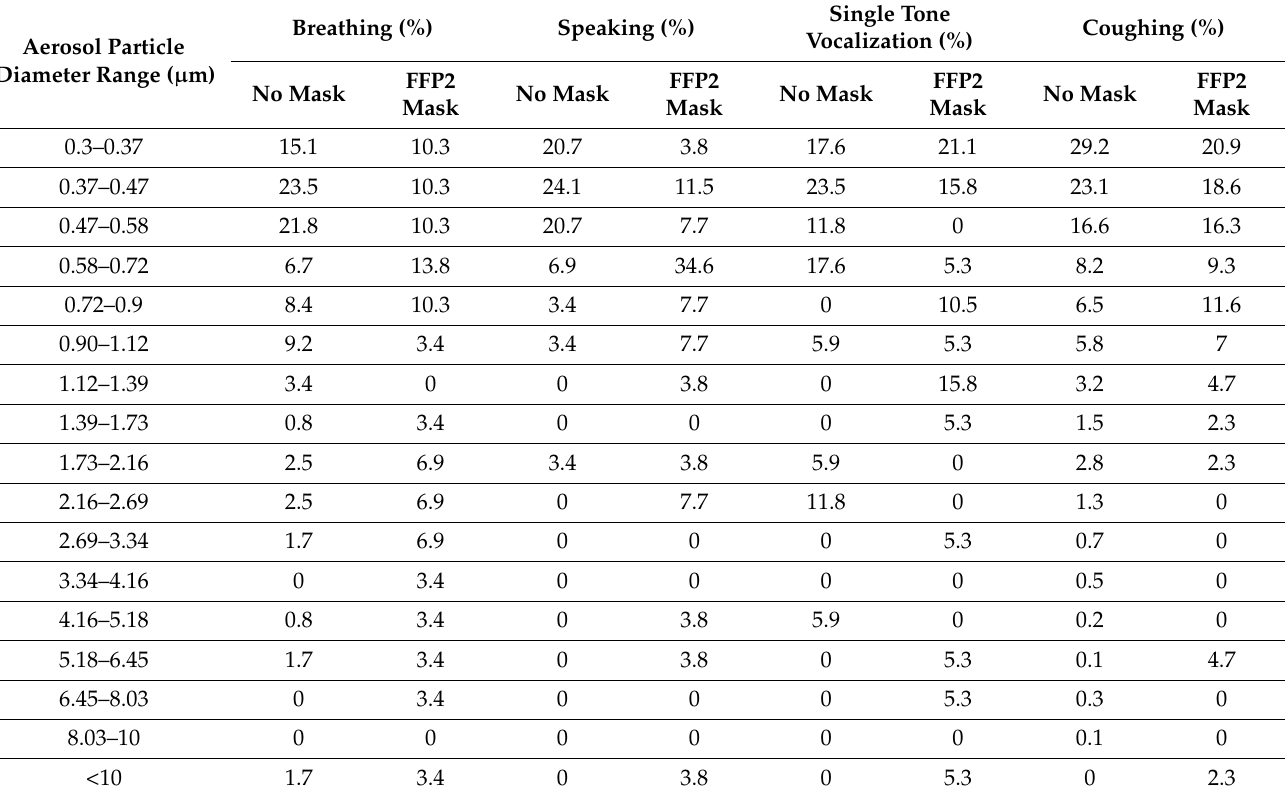
Table 3. Percentage size distribution of aerosol particles in the four basic respiratory activities in the diameter range from 0.3 µ m to 10 µ m. On average, more than 87% of the aerosol particles were smaller than 1 µ m in the experiments without a mask and 74% with an FFP2